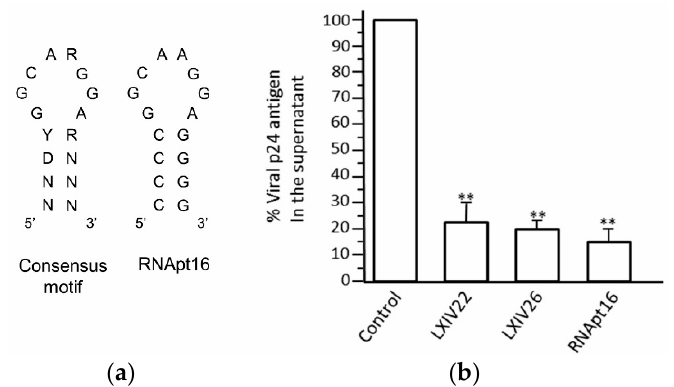
Figure 5. Inhibition of HIV-1 particles production by the RNApt16 aptamer. ( a ) Sequence and secondary structure of the 16 nt-long consensus selected structural motif and the designed RNApt16 aptamer. R, purine; Y, pyrimidine; D; A, G, or U; N, any ribonuleotide. ( b ) Inhibition of HIV-1 particles production assays. Inhibitory efficiency of RNApt16 aptamer was measured as p24 antigen production. Its activity was compared with that showed by the most frequent aptamers resulting from the SELEX procedure LXIV22, LXIV26. Data represent the mean of three independent assays. **, significant differences as compared to the control ( p < 0.01). Figure adapted from [27].